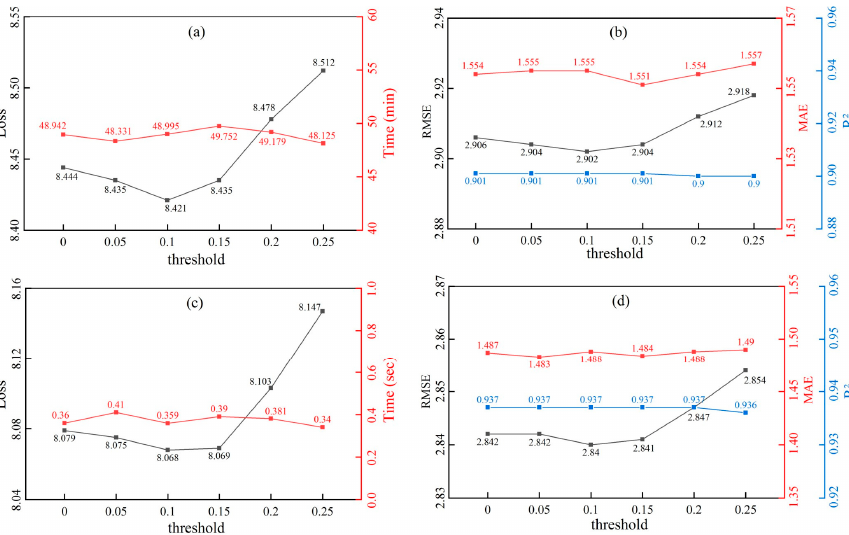
Figure 4. Comparison of model performances under different threshold on the train and test set. ( a ) Prediction loss and computational time on the train set; ( b ) Three evaluation metrics on the train set; ( c ) Prediction loss and computational time on the test set; ( d ) Three evaluation metrics on the test set.